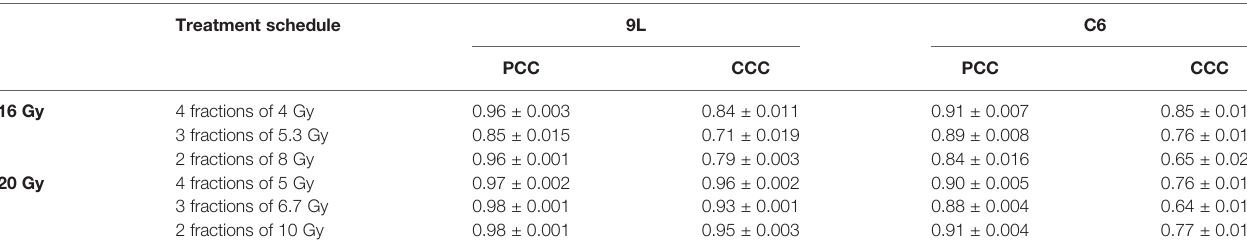
TABLE 2 | Error between model prediction and measurement. Treatment